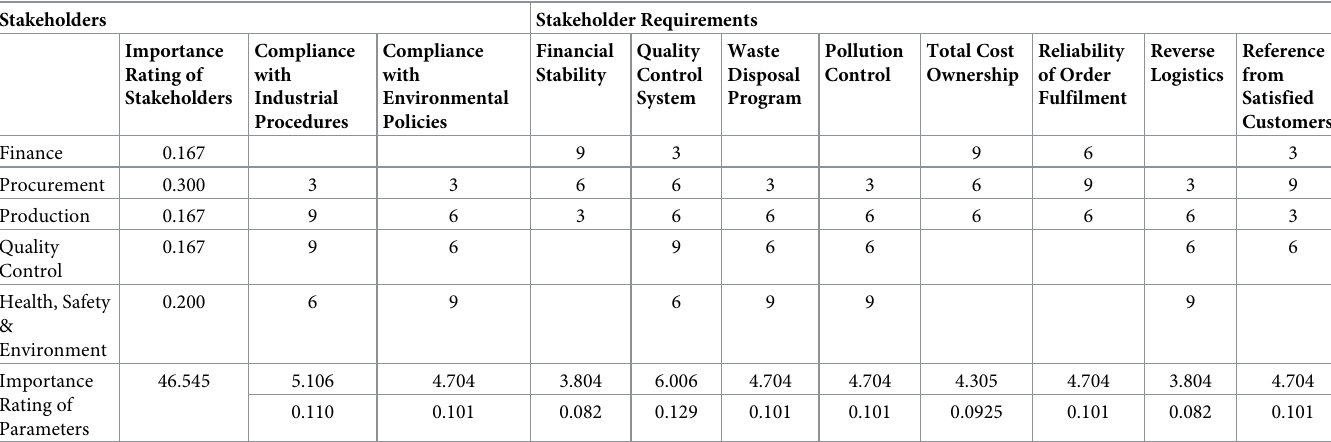
Table 4. House of quality 1.